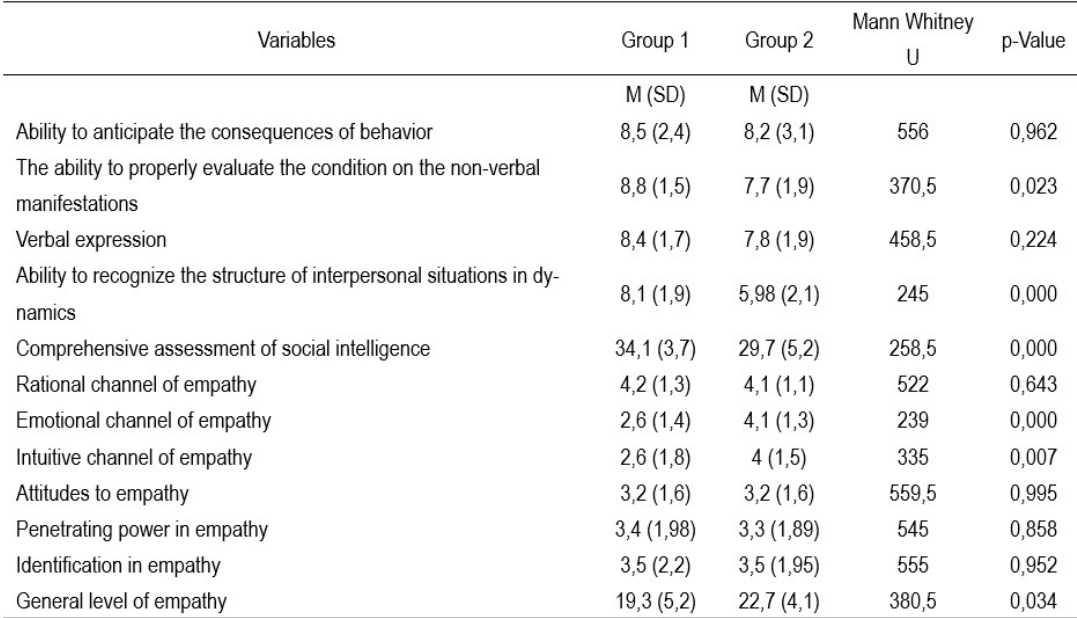
Comparative analysis of social intelligence and empathy of students with different levels of mathematical